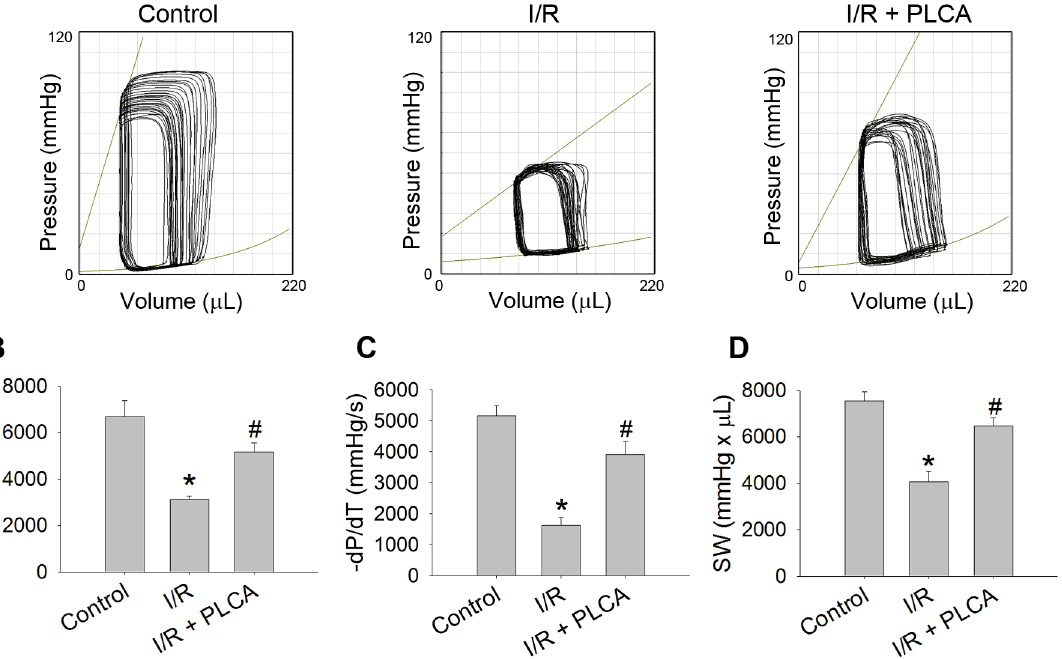
Fig 6. Effect of PLCA on cardiac function after rat subjected to myocardial I/R stress. Cardiac functions were measured by pressure-volume loop (PV loop). (A) Representative PV loop of each groups were shown. (B) Maximal slope of the systolic pressure increment (+dP/ dt), (C) maximal slope of the diastolic pressure decrement ( − dP/dt), and (D) stroke work (SW) were measured. (n = 6) * P < 0.05 vs. control, # < 0.05 vs. IR.